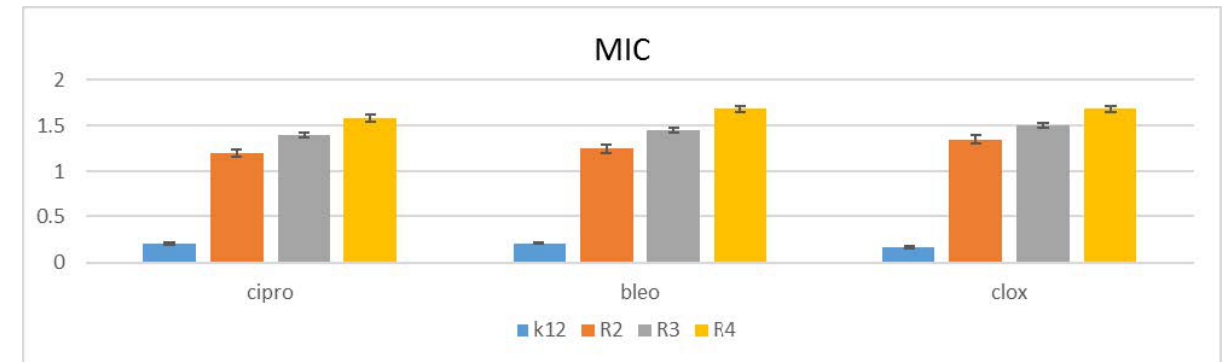
Figure 6. Percentage of bacterial DNA recognized by Fpg enzyme in model bacterial strains after ciprofloxacin, bleomycin, and cloxacillin treatment. The compounds were statistically significant at p < 0.05 — (Supplementary Materials Figure S24).